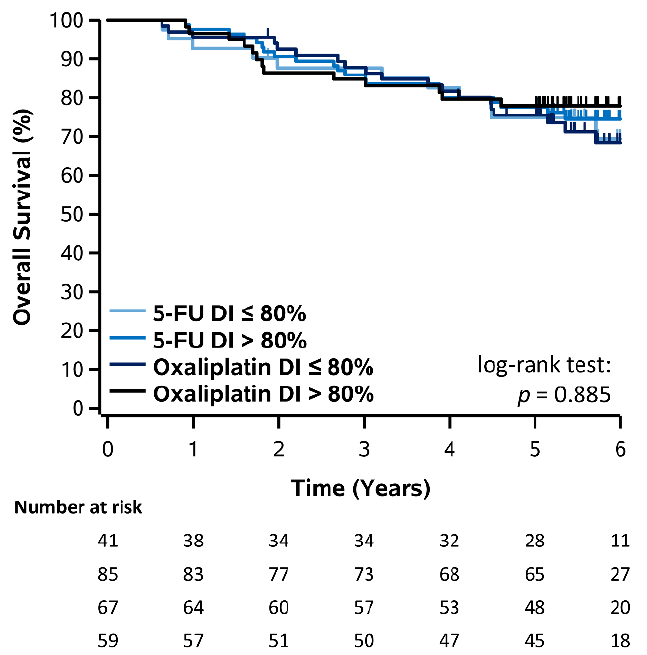
Figure 5. Kaplan–Meier plot of OS stratified by DI of 5-FU and oxaliplatin in patients receiving